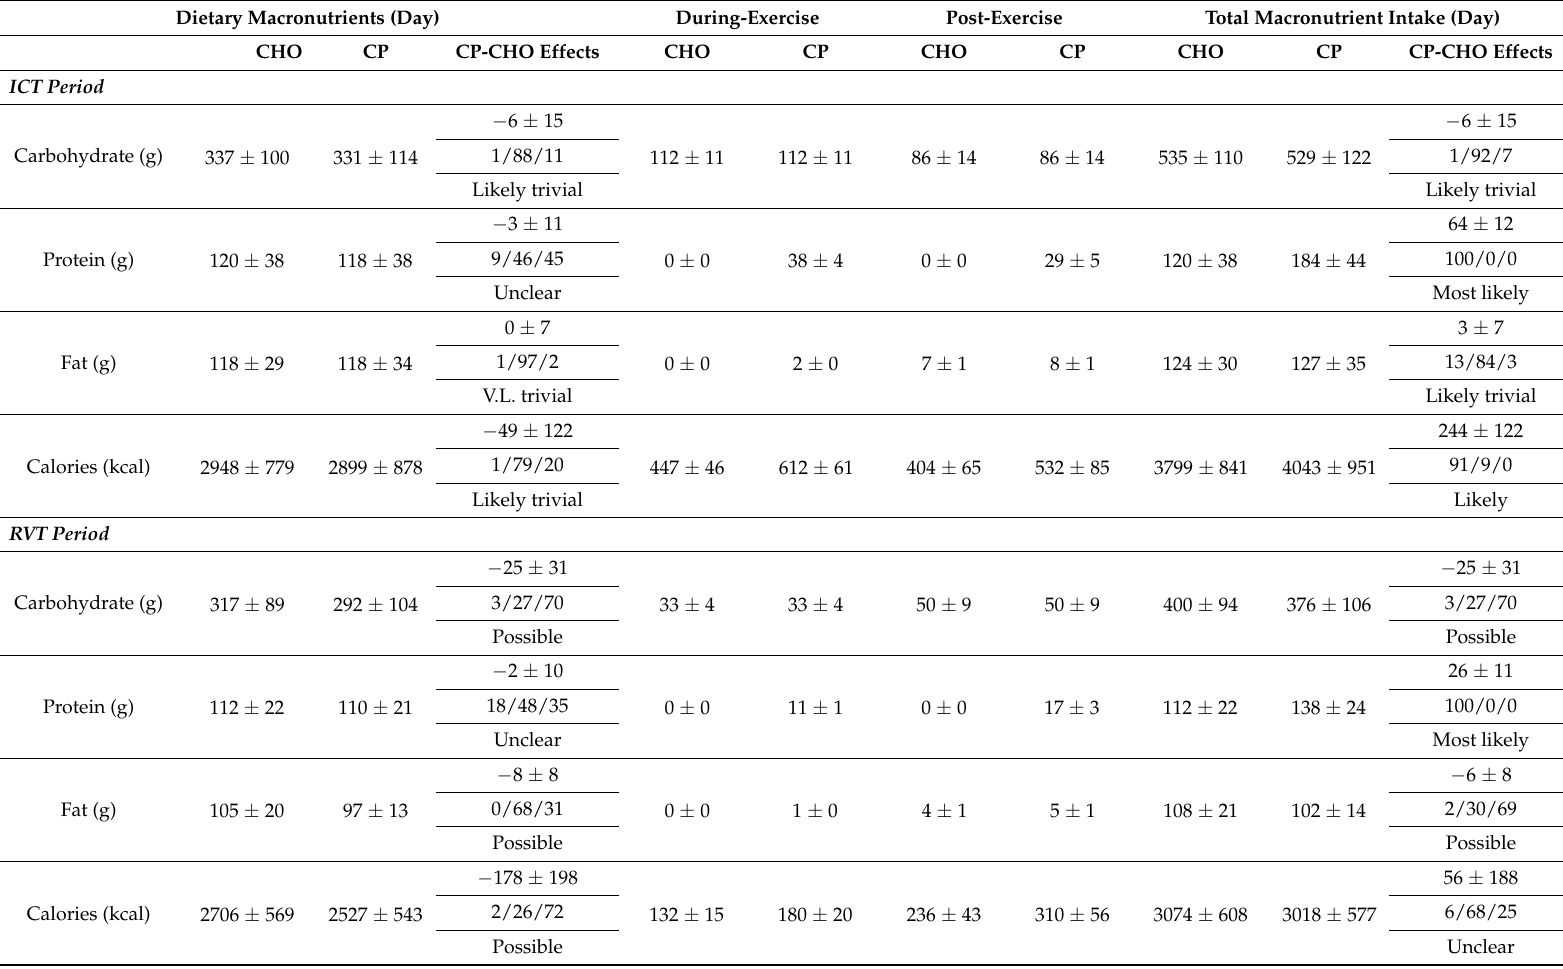
Table 2. Macronutrient Intake (Mean ± SD) during Intensified Training and Reduced-Volume